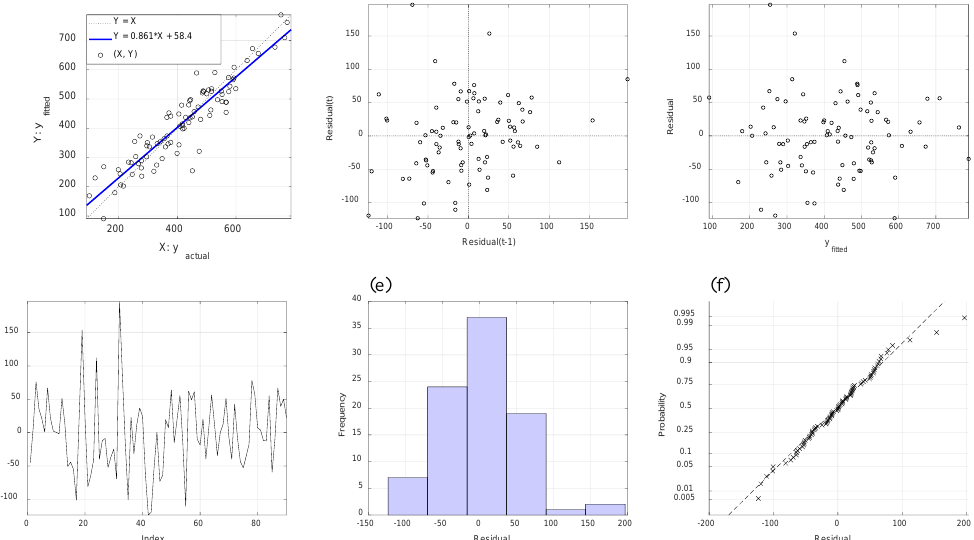
Figure 6. ( a ) scatter plot between y i and ˆ y i ; ( b ) scatter plot between r i − 1 and r i ; ( c ) scatter plot between ˆ y i and r i ; ( d ) line plot for r i ; ( e ) histogram for r i ; ( f ) normal probability plot for r i .